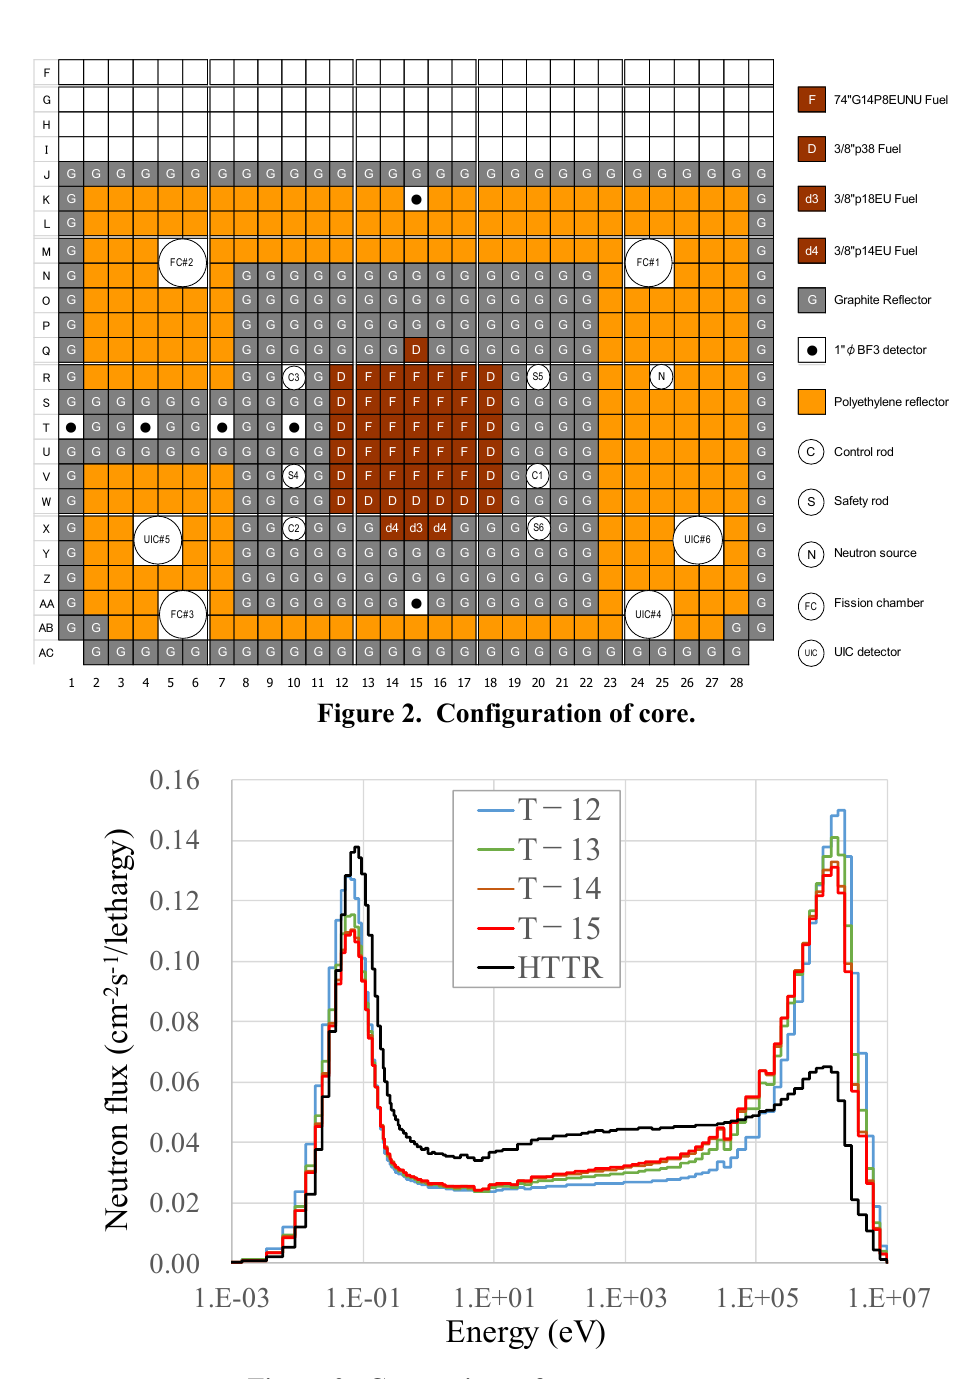
Figure 3. Comparison of neutron